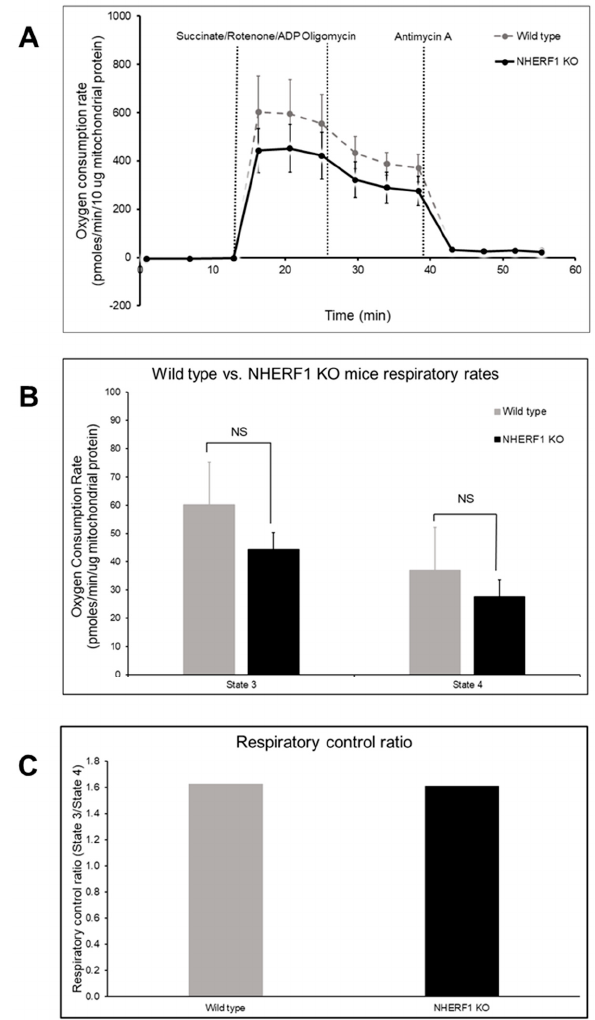
Figure 7. Mitochondrial function in isolated mitochondria of WT and NHERF1 KO kidneys. Mitochondria from two to 4-month-old male WT and NHERF1 KO mice were isolated and analyzed via the Seahorse XF24 for oxidative capacity as described in the Methods section. ( A ) Oxygen consumption rate (OCR) was recorded after the addition of both substrates (succinate/rotenone/ADP) and inhibitors (oligomycin and antimycin A) [(WT n = 6) and (NHERF1 KO n = 6)]. ( B ) State 3 and state 4 were calculated using the recorded OCRs of WT and NHERF1 KO mitochondria. Data are mean ± SD [(WT n = 6) and (NHERF1 KO n = 6)]. State 3 and state 4 respiration were considered insignificant between WT and NHERF1 KO mouse kidney mitochondria. ( C ) Respiratory control ratio (RCR) (state 3/state 4) was calculated between WT and NHERF1 KO kidney mitochondria. Data are represented as state 3/state 4 ratio [(WT n = 6) and (NHERF1 n = 6)]. RCR was insignificant between WT and NHERF1 KO mouse kidney mitochondria.